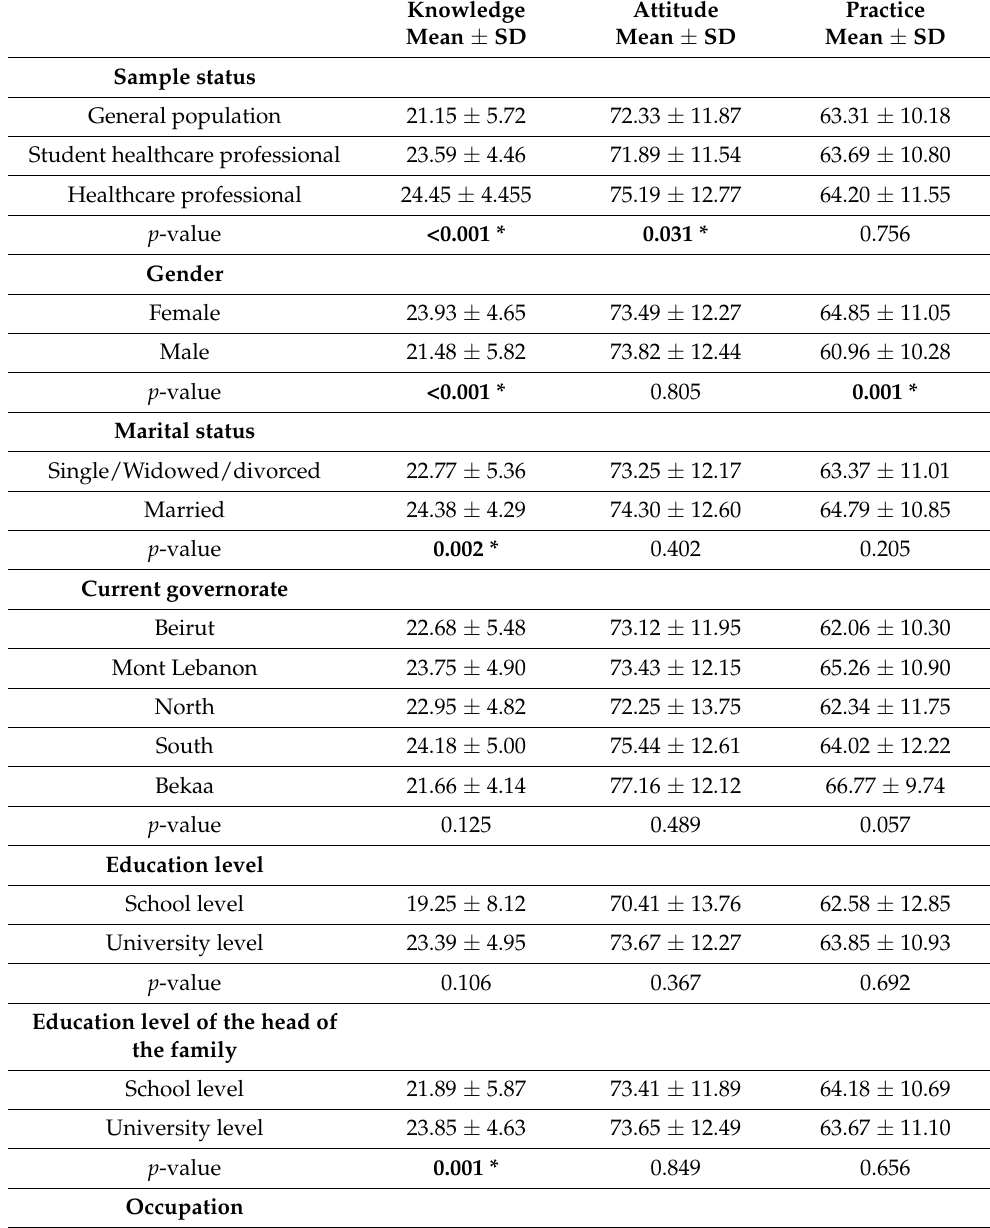
Table 5. Bivariate analysis taking the KAP scales toward cholera as the dependent